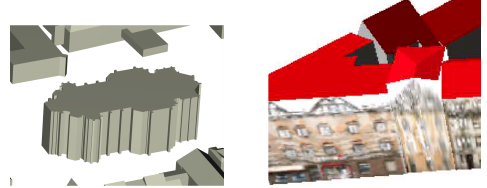
Figure 2: Shortcomings of the existing city model: Most churches are represented in LoD 1. Projection of terrestrial col- ored LiDAR points to facades shows that wall polygons do not fit with facades because of wrong roof angles and missing roof